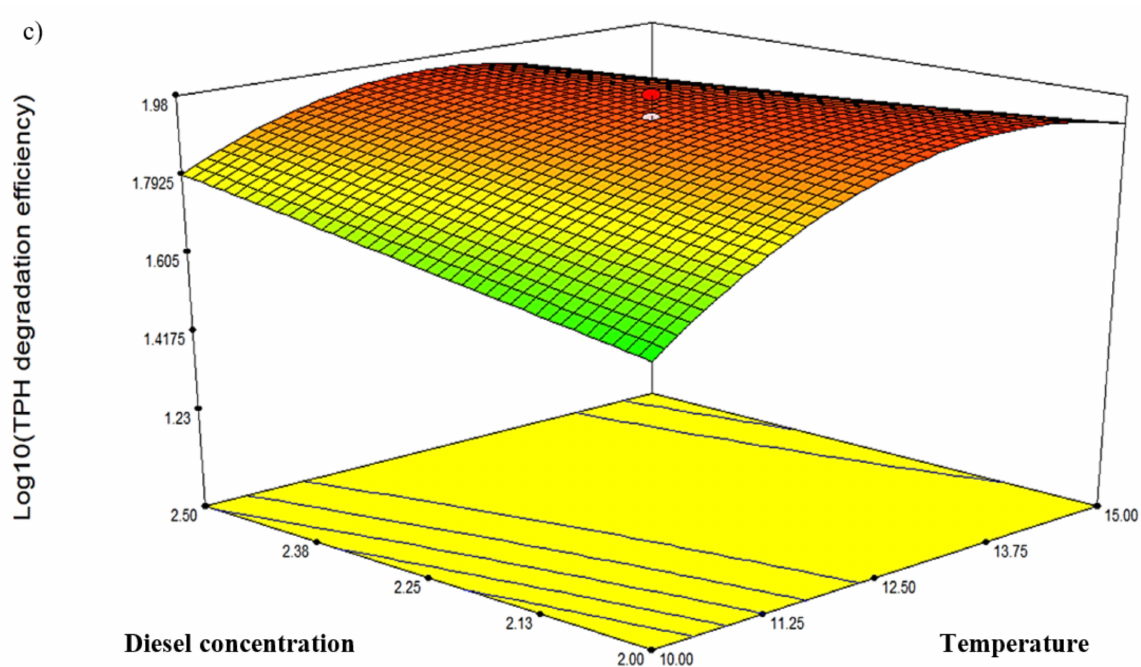
Figure 5. The three-dimensional response-surface plots showing the significant pairwise interactions between factors and the biodegradation efficiency by microbial consortium BS24. The contours ( a – c ) depict the interactions between pH and temperature, NH 4 Cl and temperature, and diesel concentration and temperature,